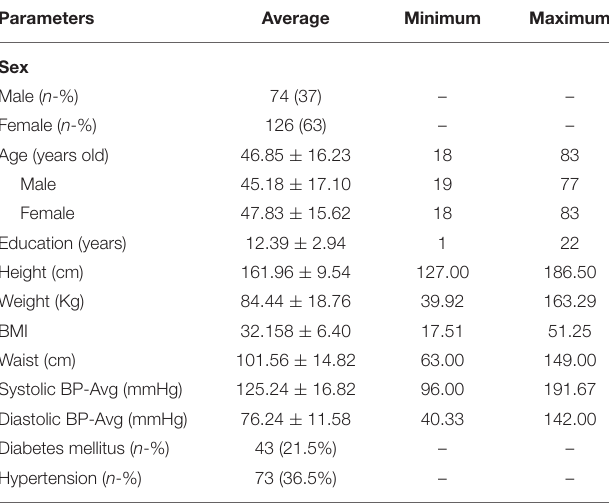
TABLE 1 | Characteristics of the study population. Parameters